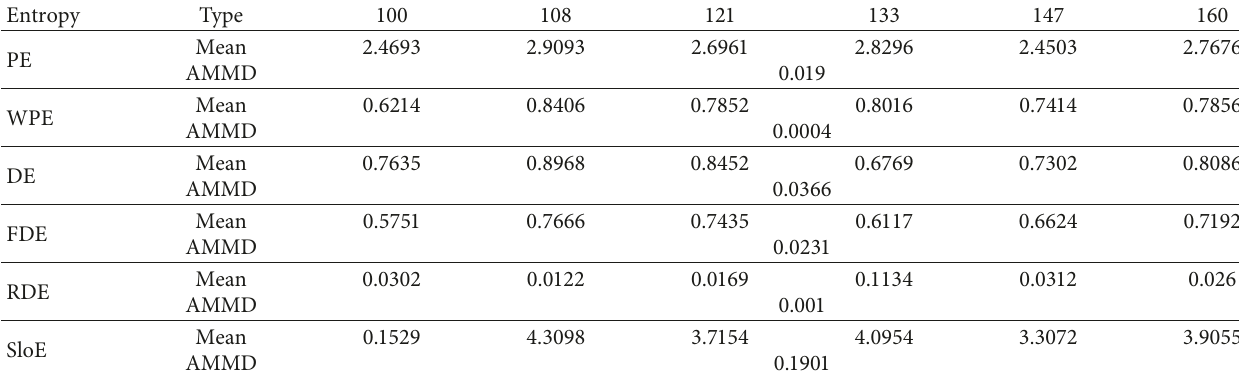
Table 2: The mean and AMMD of different